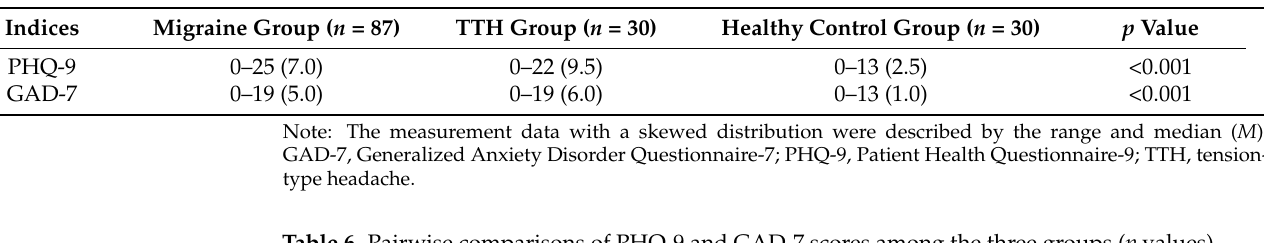
Table 6. Pairwise comparisons of PHQ-9 and GAD-7 scores among the three groups ( p